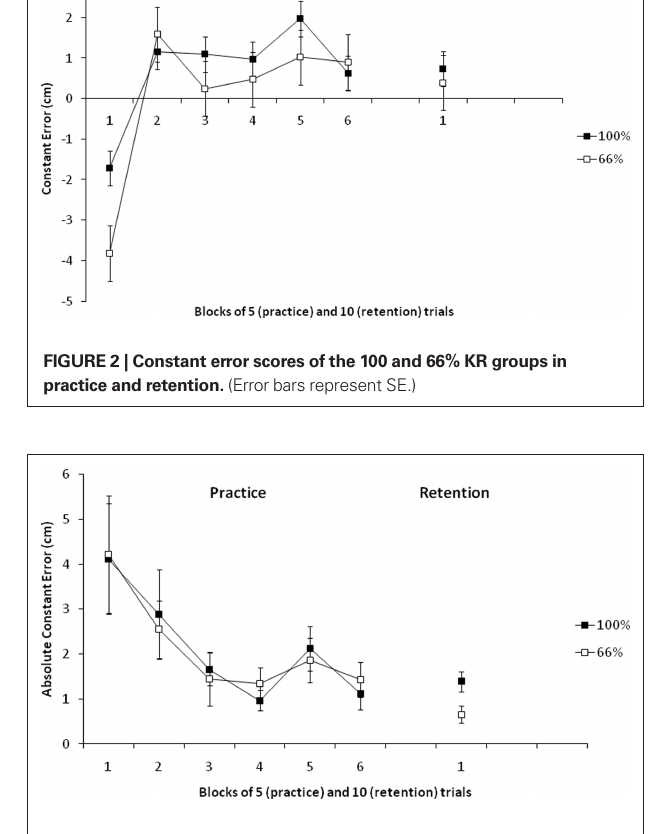
Figure 3 | Absolute constant error scores of the 100 and 66% Kr groups in practice and retention. (Error bars represent SE.)